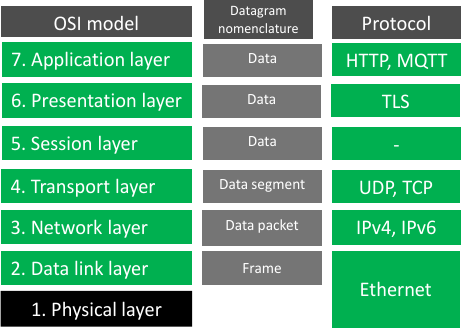
Figure 3. Model OSI-ISO Open System Interconnection—Open Source Initiative.